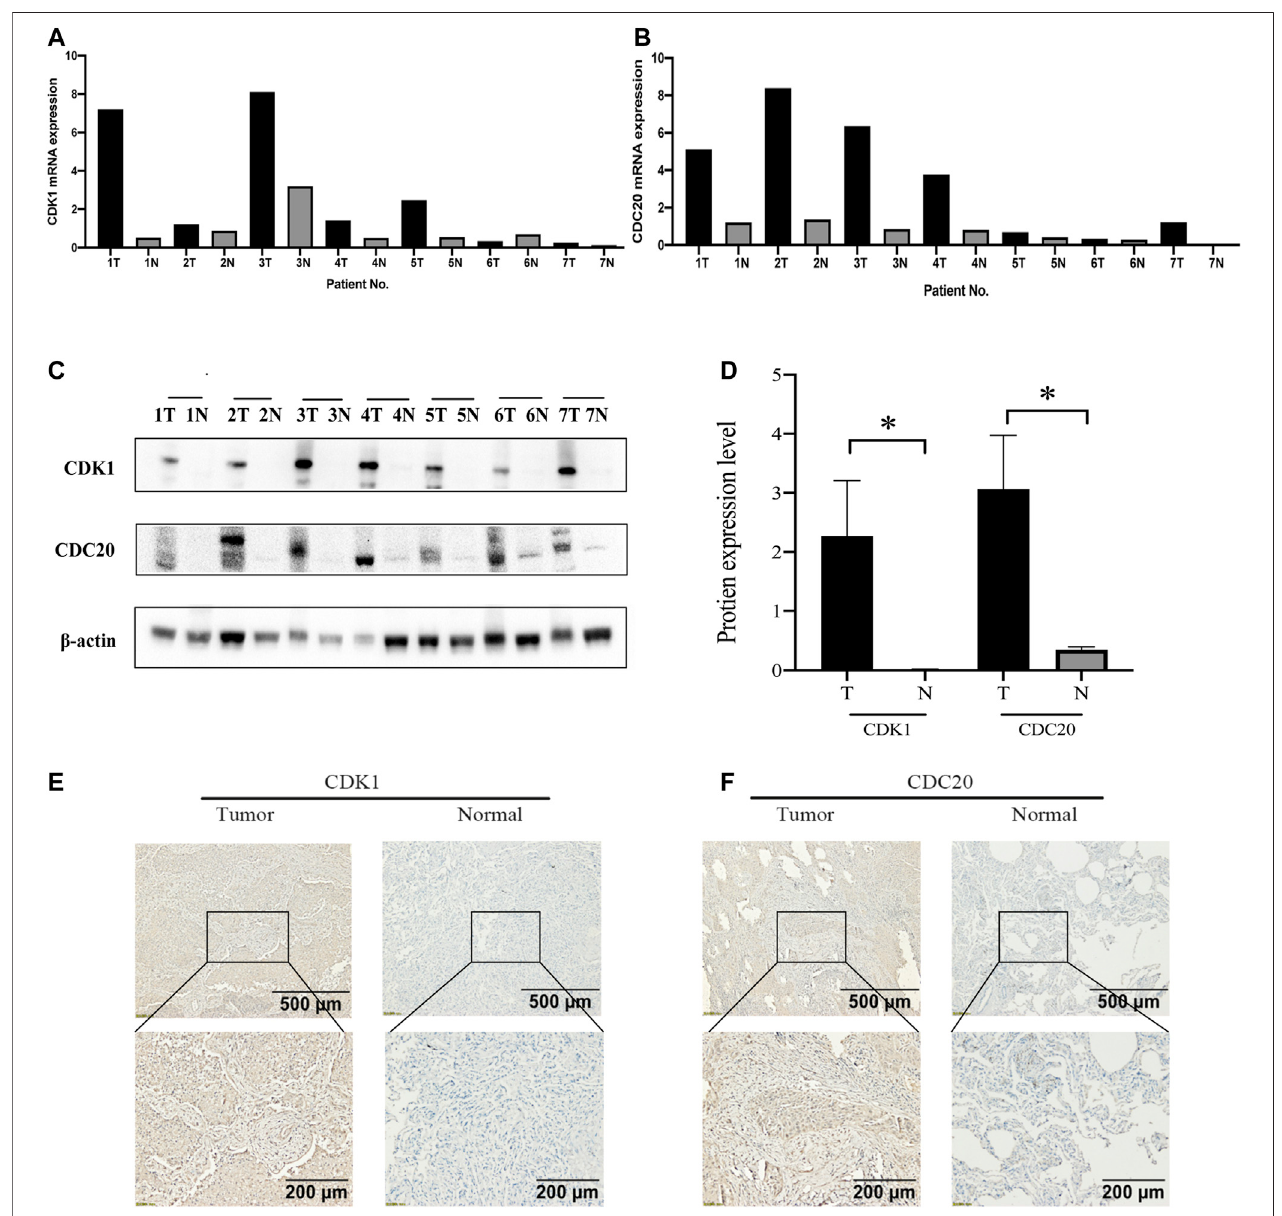
FIGURE 8 | The validation of basic experiments. Real time-qPCR manifests that CDK1 (A) and CDC20 (B) in LUSC tissues are higher than normal lung tissues at the mRNA expression level. Western blot reveals that CDK1 and CDC20 in LUSC tissues are obviously higher than normal lung tissues at the protein expression level (C,D) . Immunohistochemistry (IHC) results reveal that CDK1 (E) and CDC20 (F) are overexpressed in LUSC tissues compared with normal